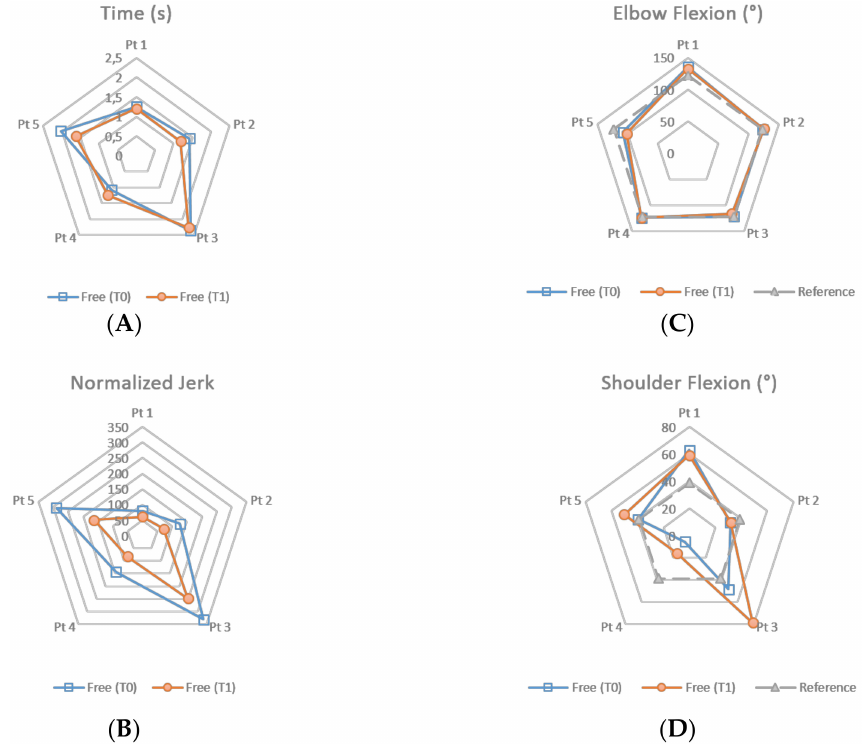
Figure 3. Radar plots of four kinematics parameters recorded during freely executed HTMM, namely the duration of the forward phase ( A ), normalized jerk ( B ), elbow flexion at the end of the movement ( C ), and shoulder flexion angle ( D ). For each patient (Pt1, Pt2, Pt3, Pt4 and Pt5) the values at T0 (blue line) and T1 (red line) are shown. For the angles, the reference values (grey dashed line) computed on the trajectory performed by a trained clinician (corresponding to the one imposed by the robot during the rehabilitation), were reported as